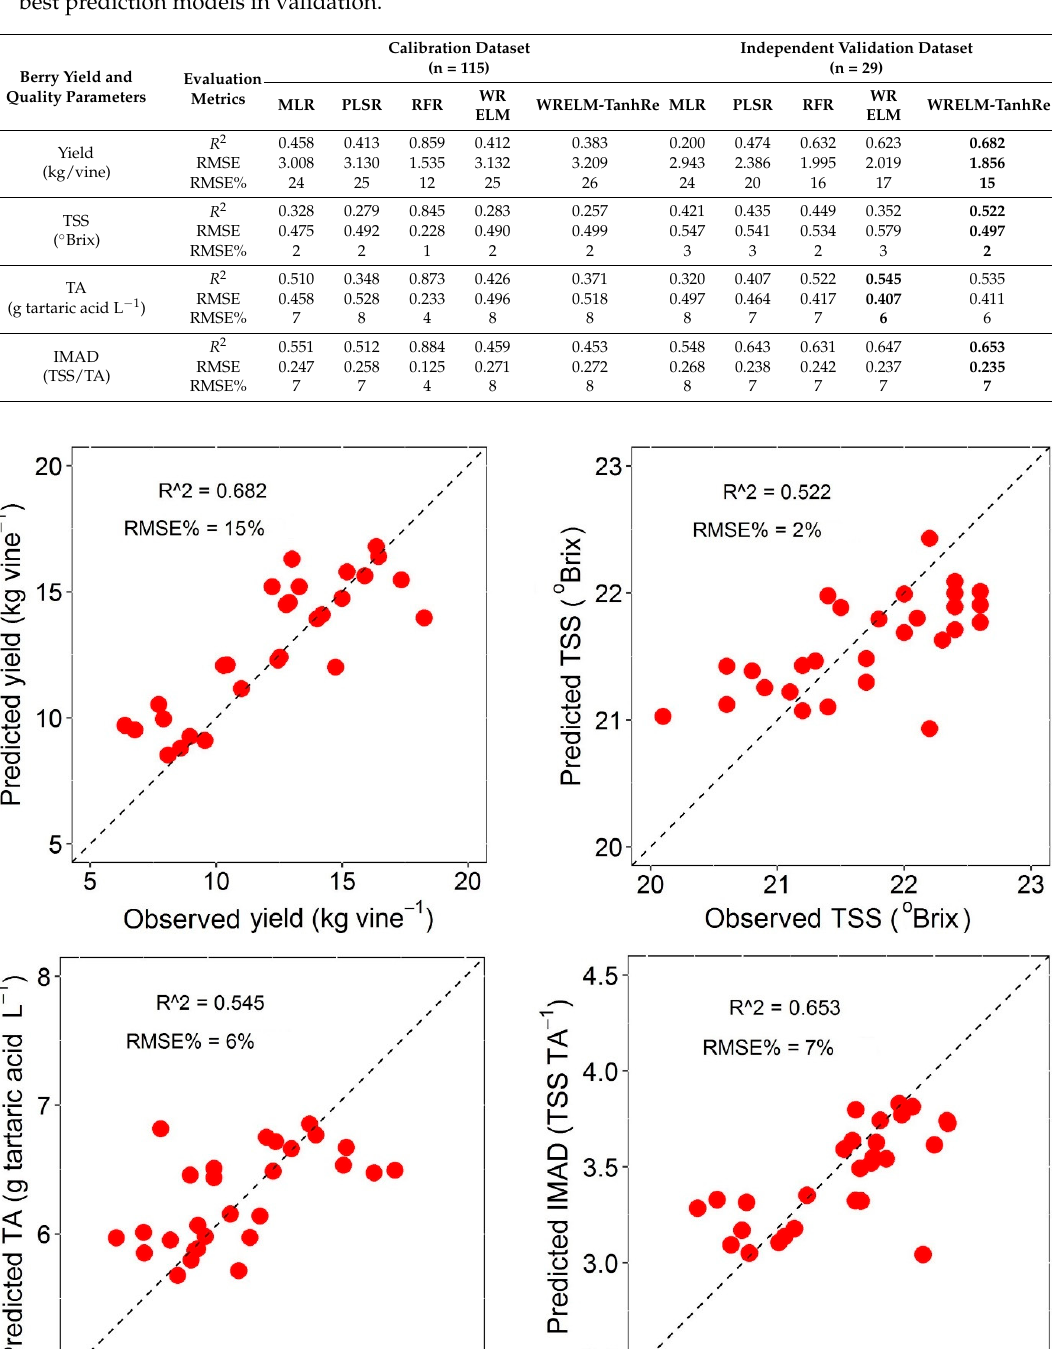
Table 4. Results of the model performance for predicting berry yield and quality. Bold fonts for the best prediction models in validation.